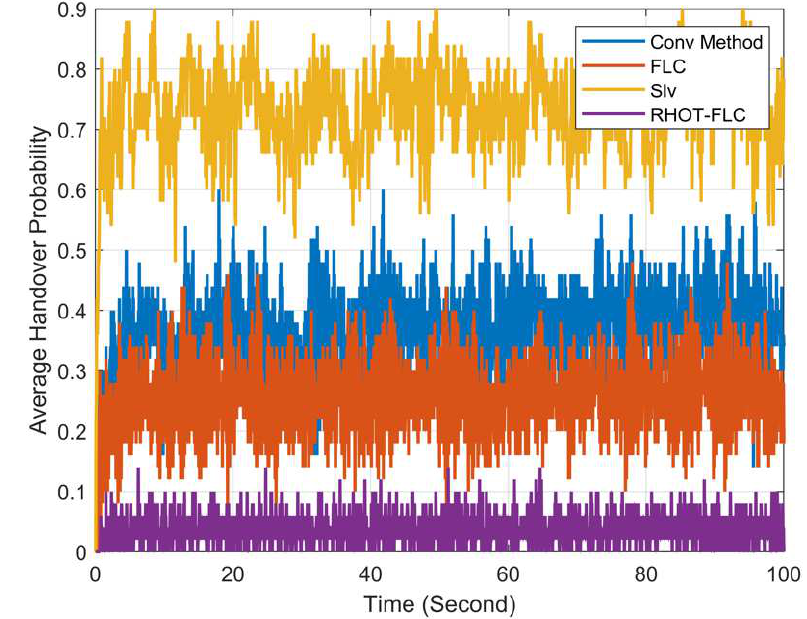
Figure 4. Average HO probability for overall mobile speeds and simulation times.